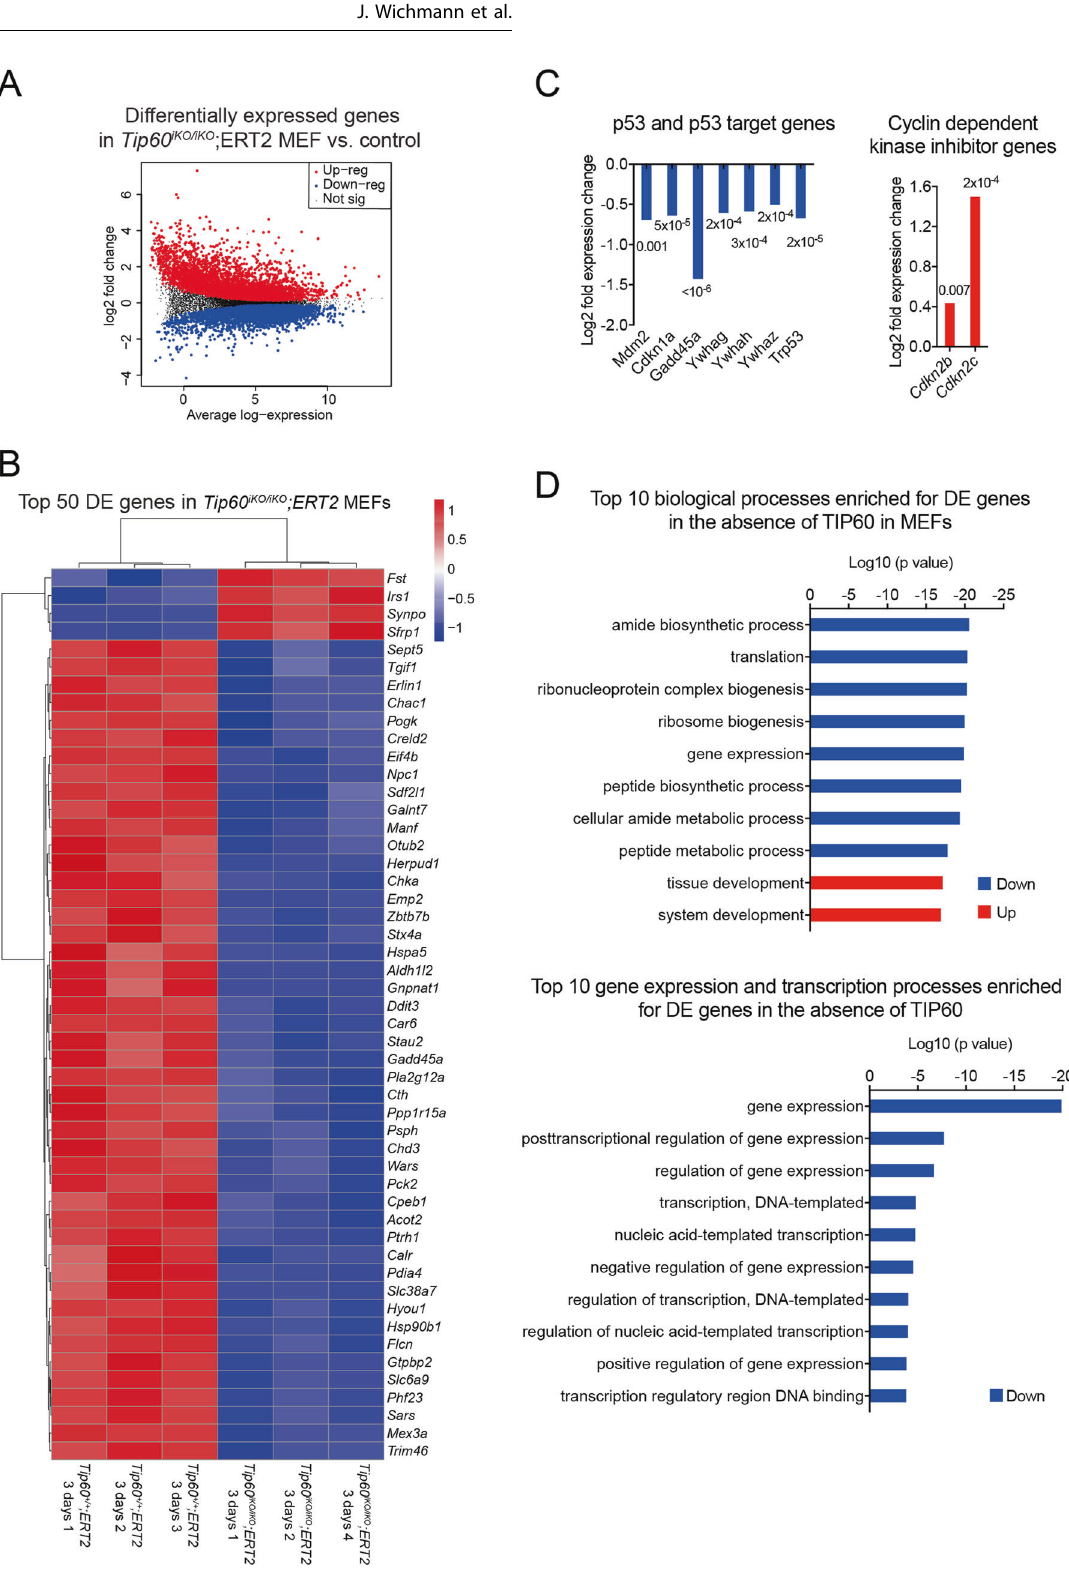
transcriptional dysregulation of multiple genes required in different phases of the cell cycle for a range of cellular mechanisms, in a manner independent of tumor suppressor and cell cycle regulators. The effects of TIP60 deletion might differ depending on the phase of the cell cycle when individual cells fi rst